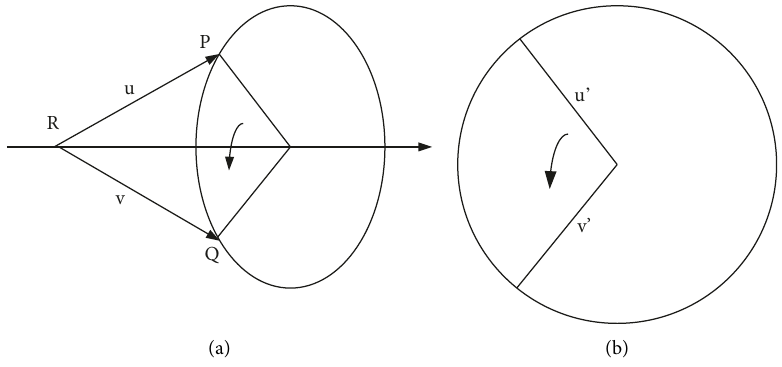
Figure 5: Schematic diagram of subproblem